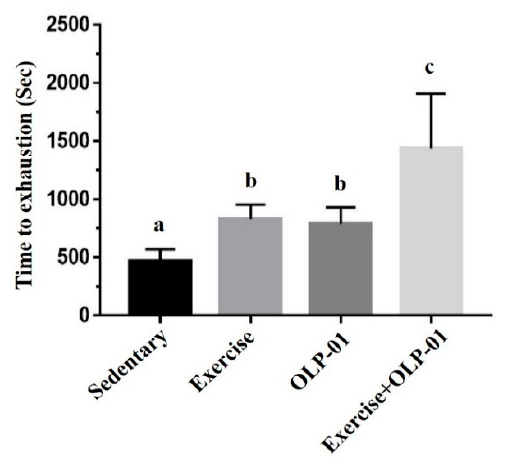
Figure 3. Effects of six weeks of exercise and probiotic interventions on exhaustive swimming time. Columns with different letters (a, b, c) were significantly different at p < 0.05.